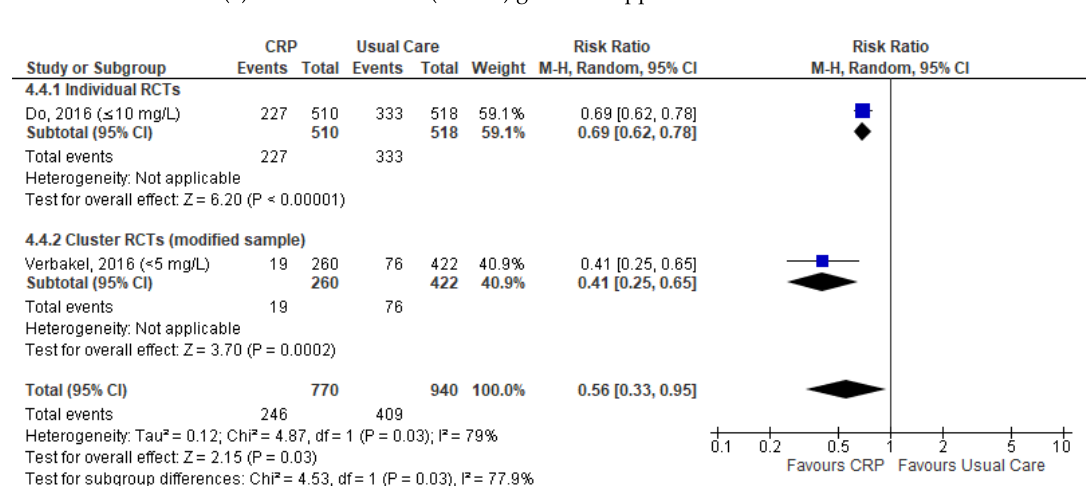
Figure 5. Comparison: CRP-POCT versus usual care. Antibiotic prescribing at index consultations by age group with CRP (cut-off) guidance to withhold antibiotics: ( a ) Adults; ( b ) Children. CRP values recommended to withhold antibiotics are presented within brackets. CRP, C-Reactive Protein (Point Of Care Test); RCTs, Randomised Controlled Trials; M-H, Mantel-Haenszel; CI, Confidence Interval; df, degrees of freedom; I 2 , heterogeneity between trials.